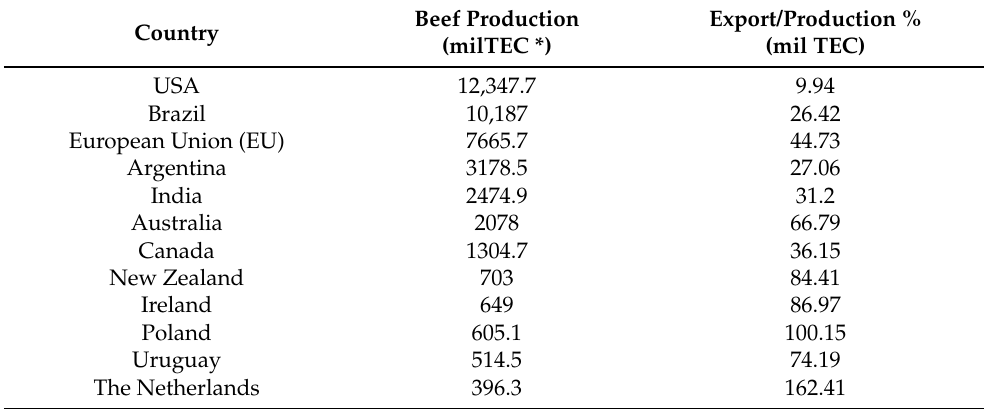
Table 1. Largest Beef Producers and Export